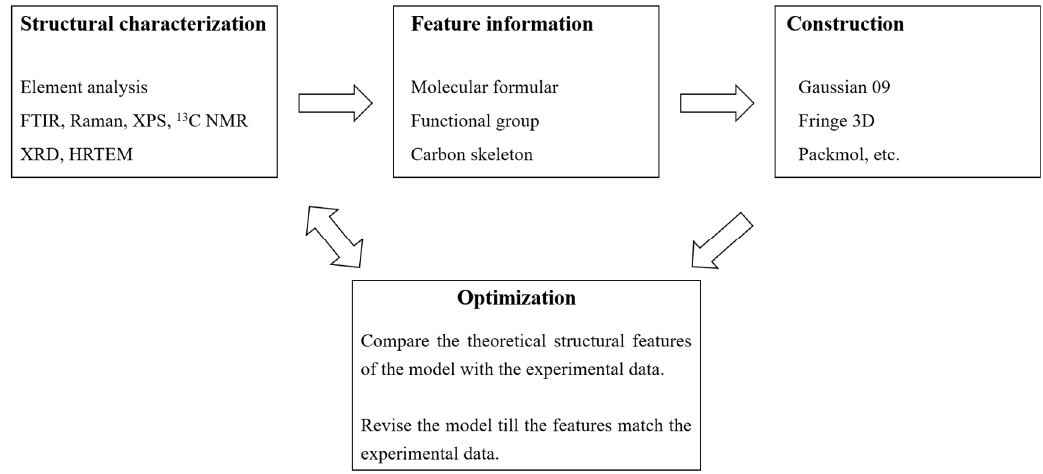
Figure 19. The general procedure of construction of a molecular structural model.